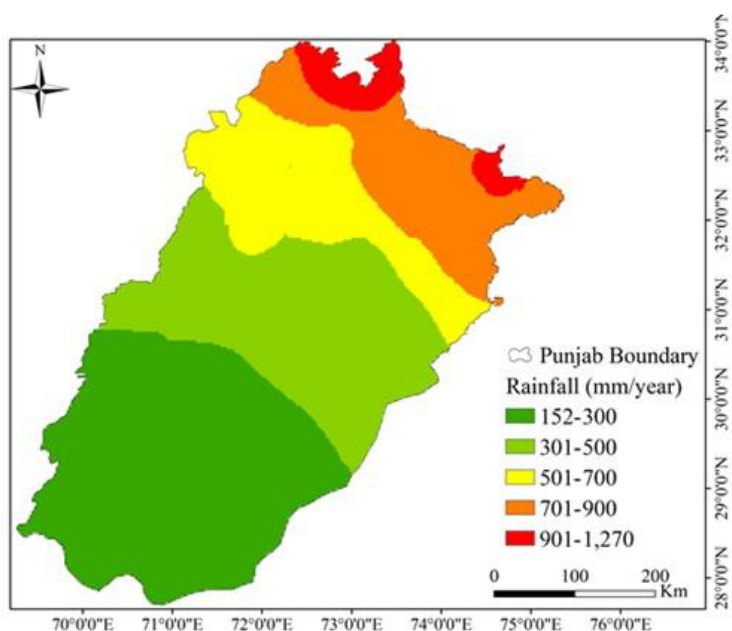
Figure A1. over the Punjab Province of Pakistan. Figure A1. Over the Punjab Province of